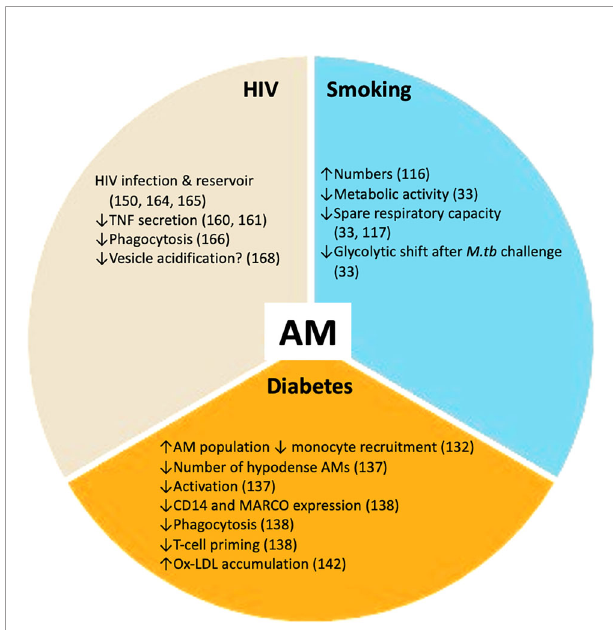
FIGURE 2 | TB co-morbidities impact alveolar macrophages (AMs). Smoking, HIV infection and diabetes mellitus perturb the healthy alveolar macrophage phenotype. These co-morbidities promote changes in alveolar macrophage metabolism and essential functions including phagocytosis and cytokine secretion. These disturbances render the alveolar macrophage population more susceptible to M.tb infection. ↑ increased; ↓